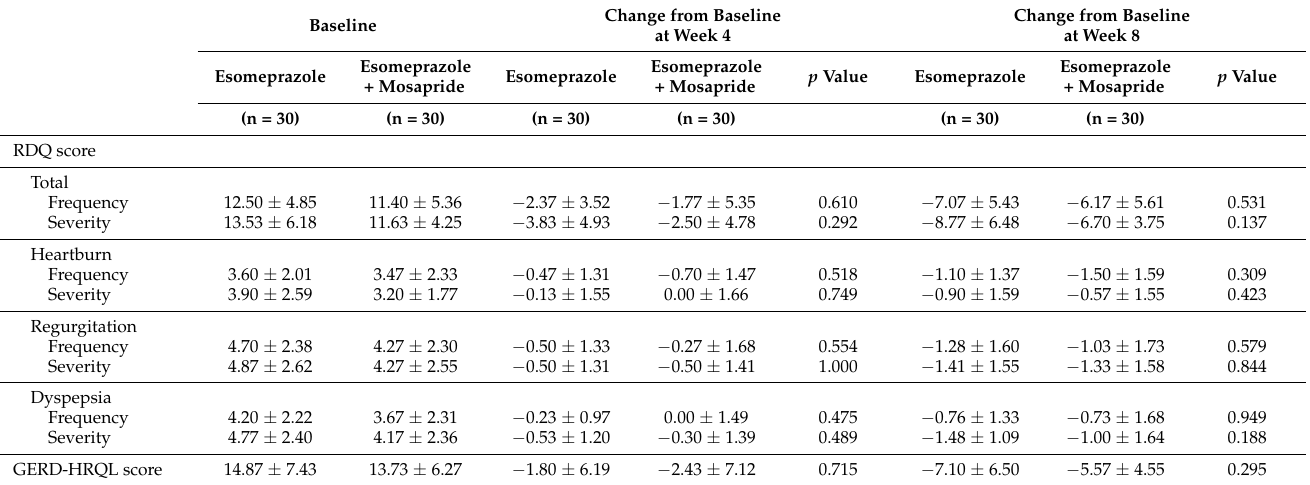
Table 4. Changes of reflux-disease questionnaire and gastroesophageal health-related quality of life scores from baseline at four- and eight-week